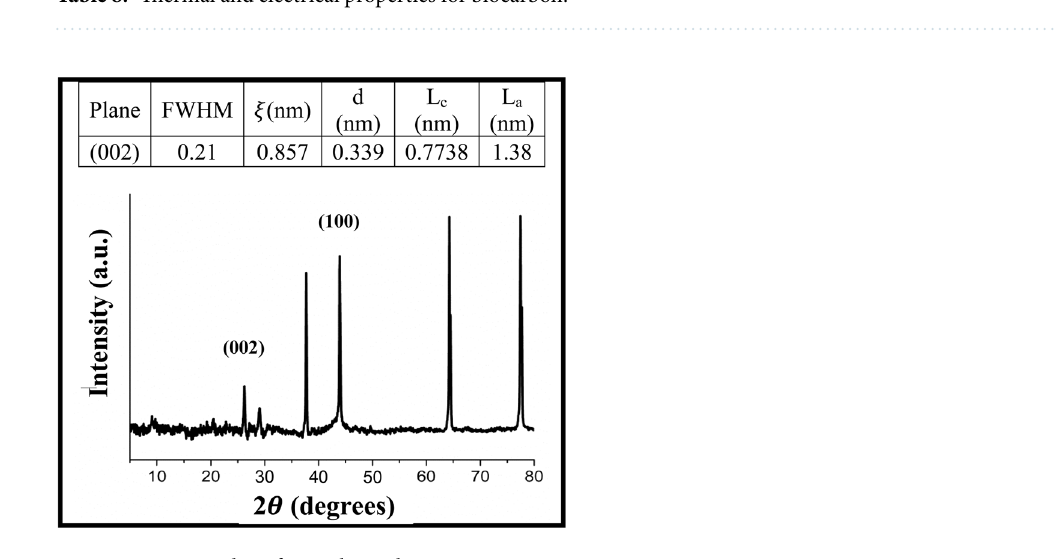
Figure 8. XRD analysis for PH biocarbon at 500